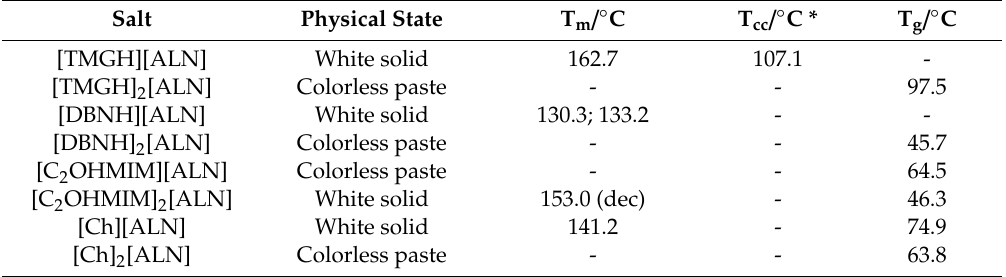
Table 1. Physical state, melting (T m ), cold crystallization (T cc ) and glass transition (T g ) temperatures of the prepared ALN–OSILs.